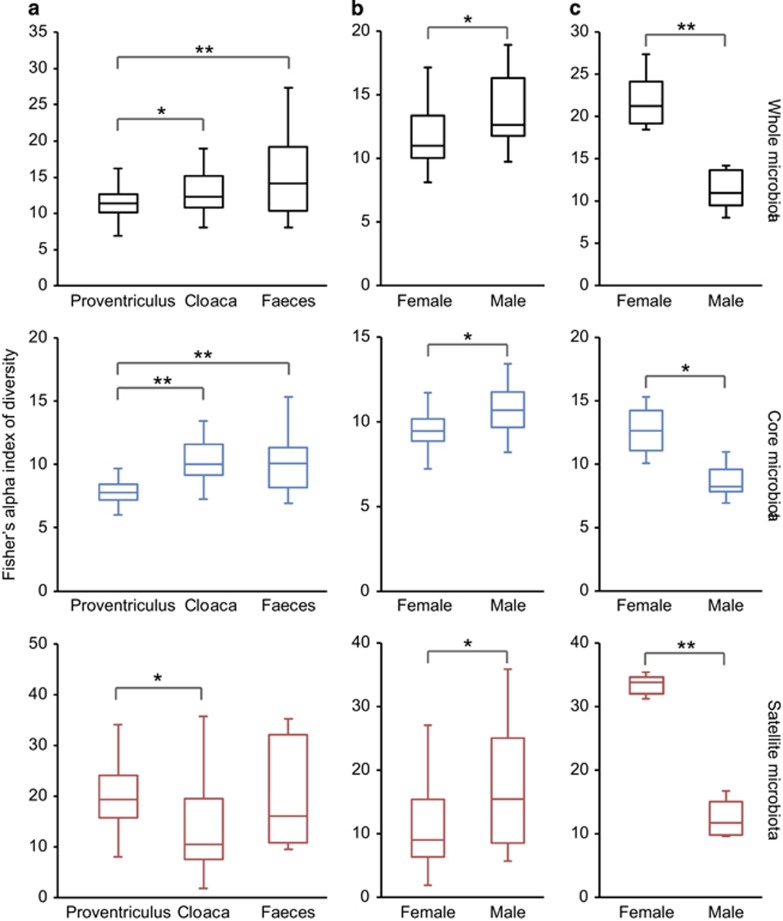
Box-plot comparisons of bacterial diversity, using Fisher's alpha index of diversity, of the whole, core and satellite microbiota (a) between microbiomes, and by host sex within the (b) cloacal and (c) faecal microbiomes. The top and bottom boundaries of each box indicate the 75th and 25th quartile values, respectively, and lines within each box represent the 50th quartile (median) values. Ends of whiskers mark the lowest and highest diversity values in each instance. Asterisks denote significant differences in comparisons of diversity at the P<0.05 level determined by two-sample t-tests (*P<0.05 and **P<0.005).